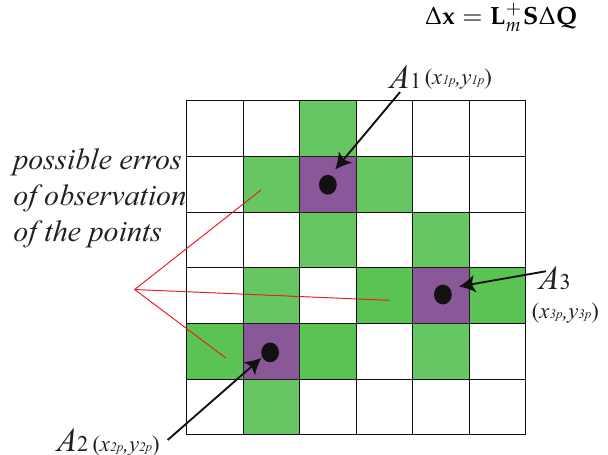
Figure 9. Error on the three points discrete